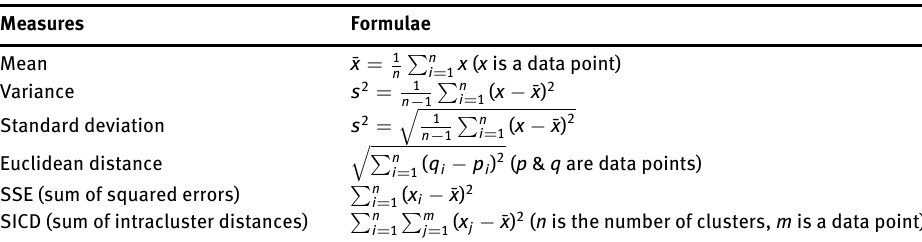
Table 4: Evaluation